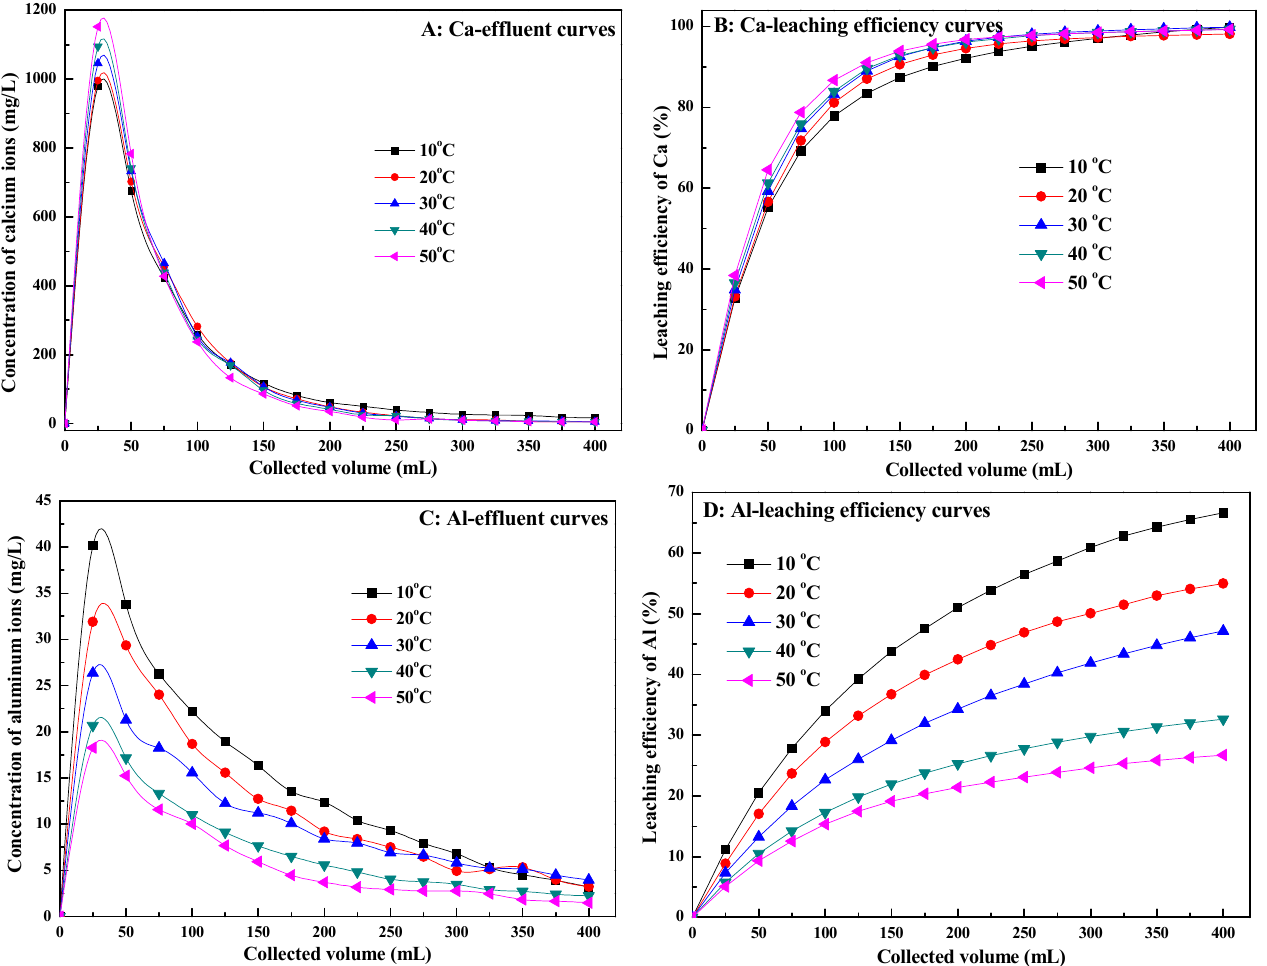
Figure 13. Column leaching behaviors of calcium and aluminum at different leaching temperatures (C 0 = 0.20 mol/L, υ = 0.60 mL/min, pH = 5.70). ( A ) Ca-effluent curves, ( B) Ca-leaching efficiency curves, ( C ) Al-effluent curves, ( D ) Al-leaching efficiency curves)